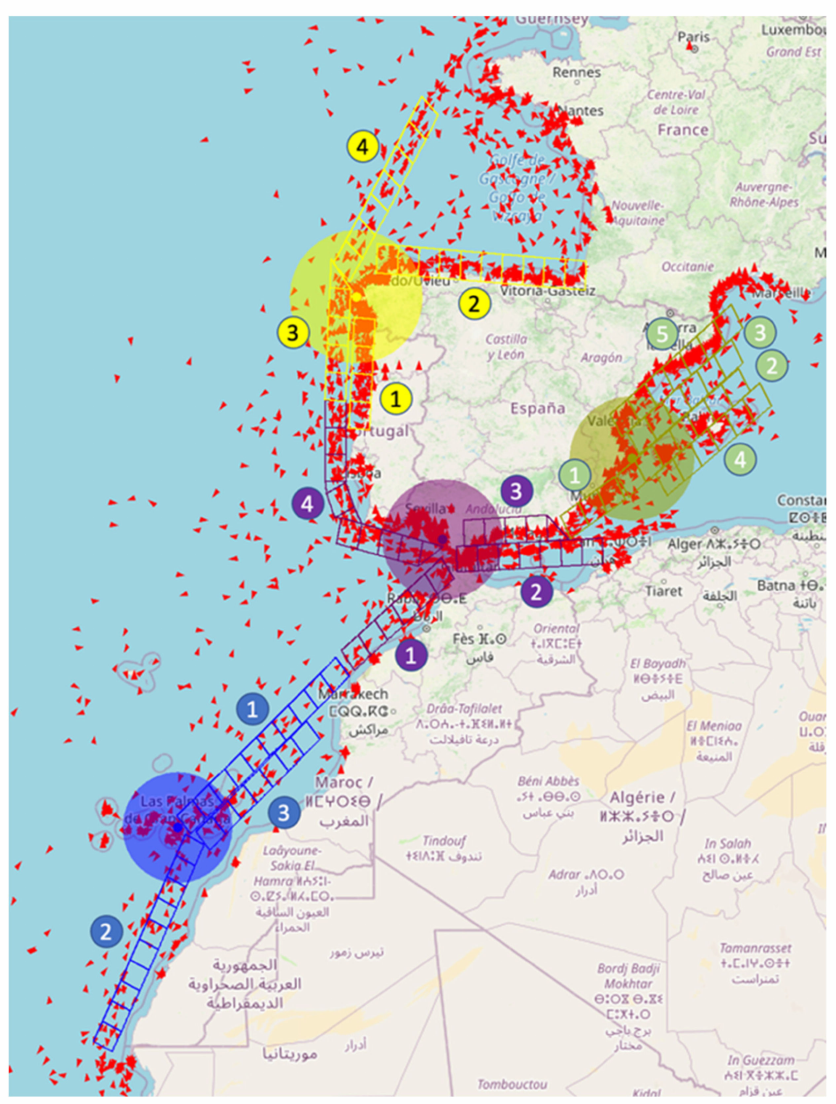
Figure 6. Image from the simulator used, corresponding to one moment of more than 50,000 that were